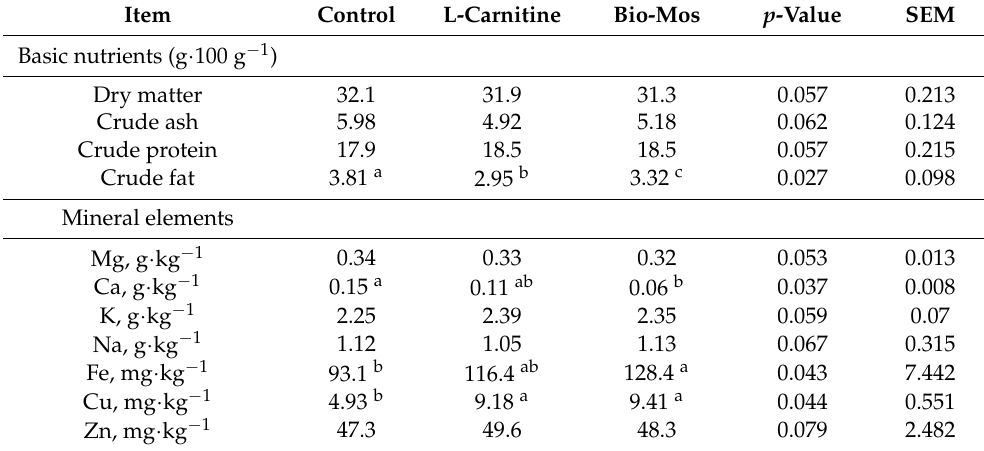
Table 7. Content of basic nutrients and mineral elements in female turkey’s liver 1 .